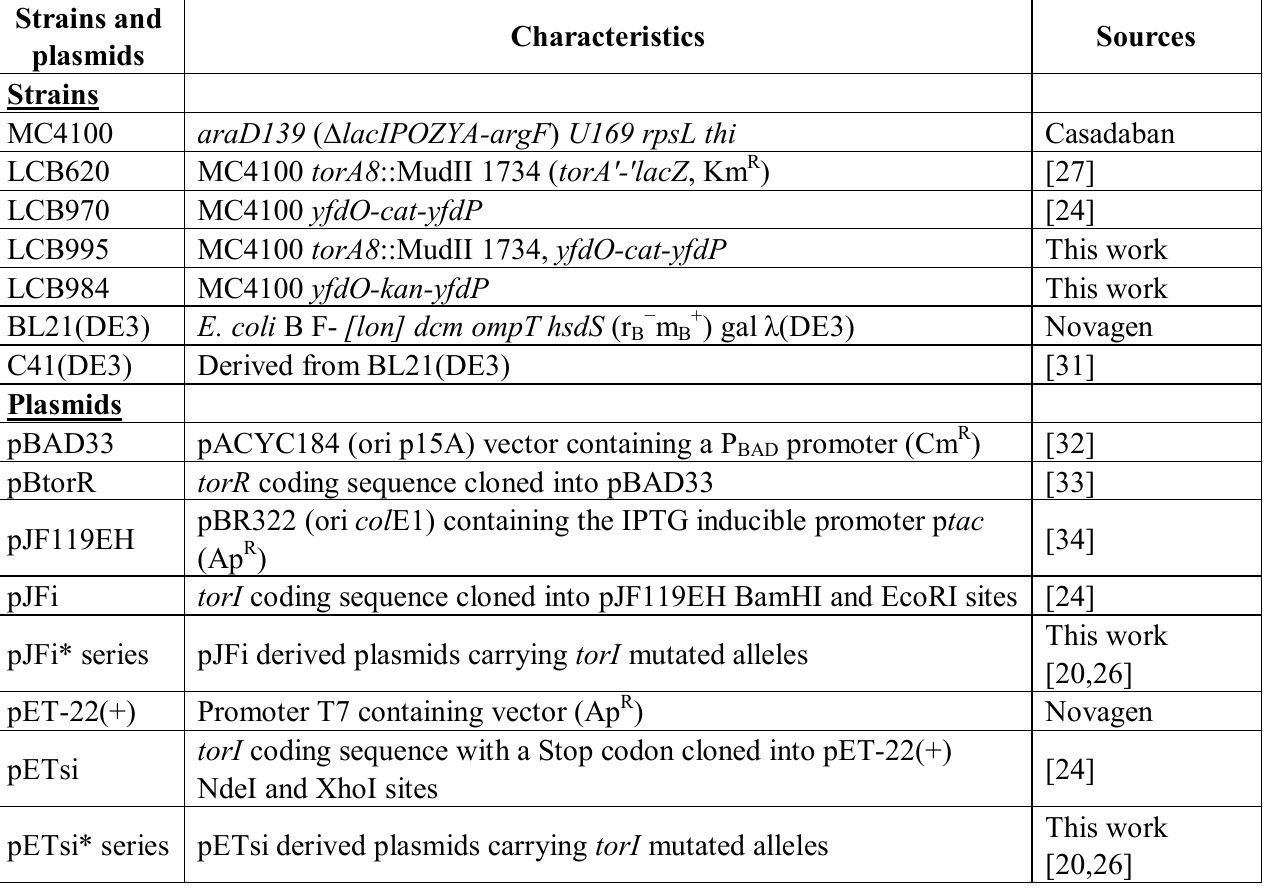
Table 2. Strains and